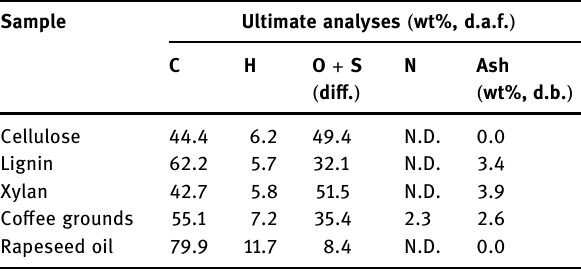
Table 1: Ultimate analyses and ash contents of samples used